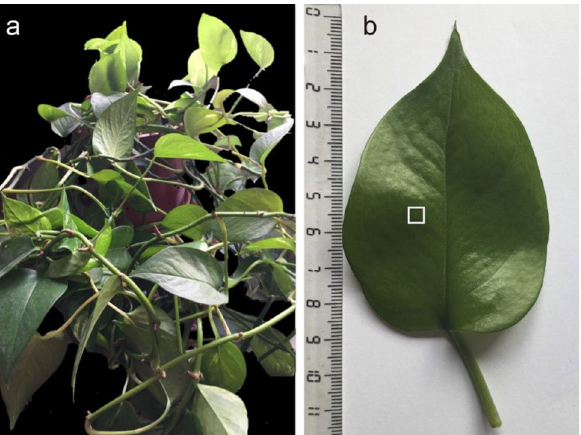
Figure 1. Plant specimen used for the present study: ( a ) Epipremnum aureum general view; ( b ) one of the measured Epipremnum aureum